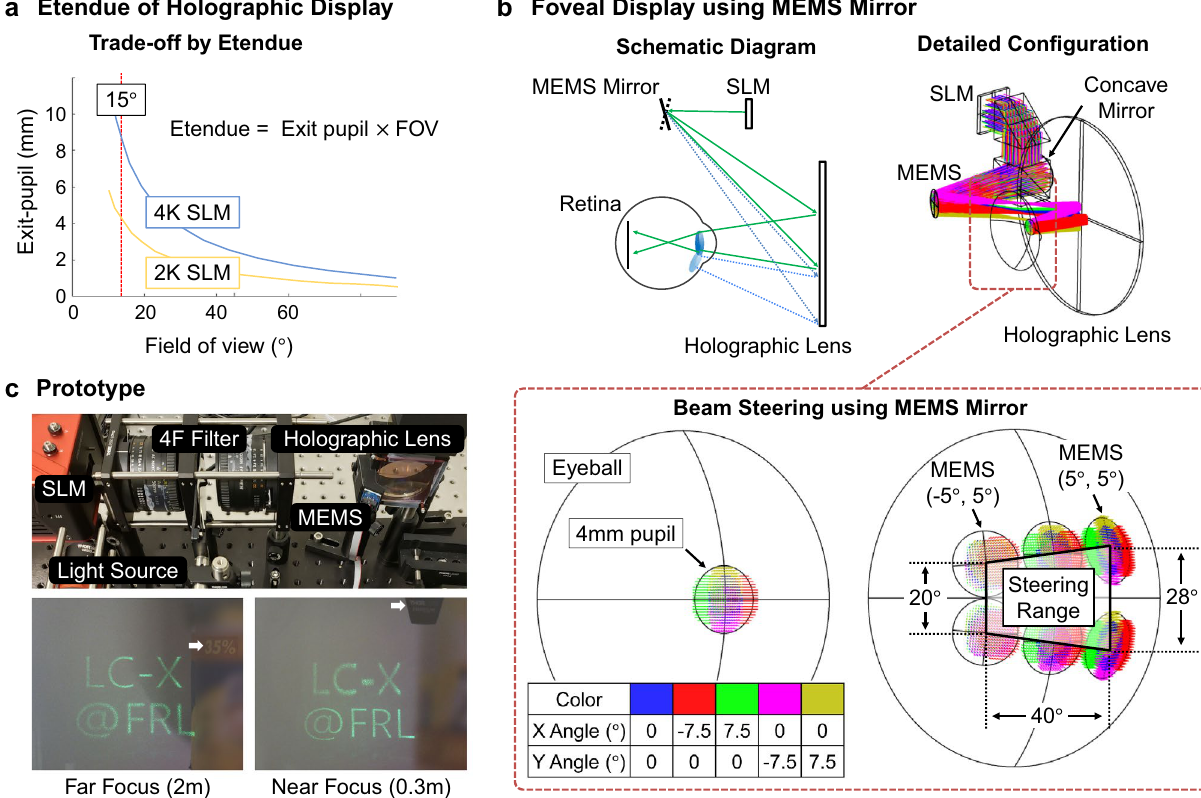
Figure 2. Illustration of a foveal holographic display with an optical steering system. ( a ) The trade-off between exit pupil and field of view in holographic displays, which is not an issue in narrow field of view system. ( b ) Schematic description of foveal display using a MEMS mirror to steer angular position of viewing window. Detailed optical configuration for a prototype is supported by Zemax simulation. ( c ) Implementation of a prototype for the foveal holographic display. Focus cue reconstruction is demonstrated by experimental results. Due to copy right permission, we blurred portion of the